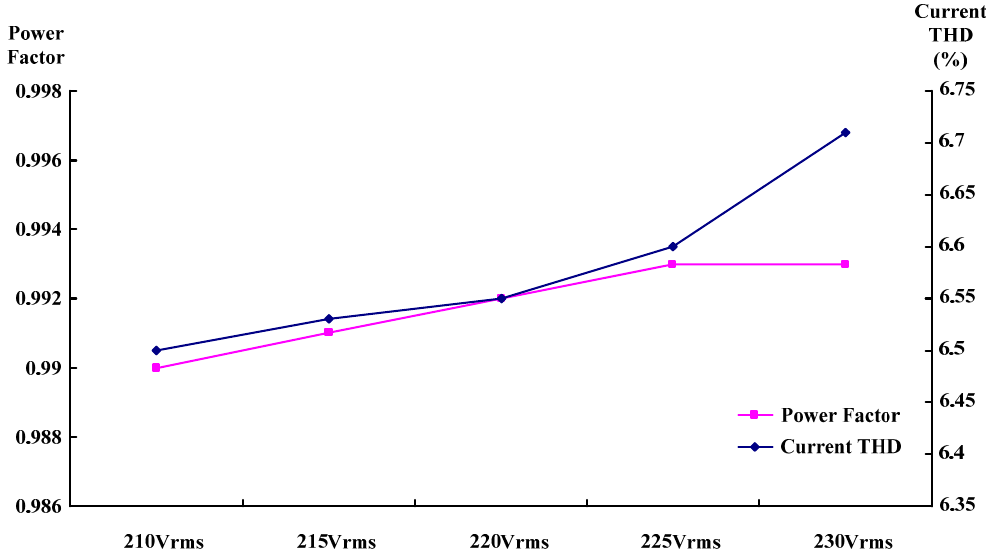
Figure 16. Measured power factor and current total harmonic distortion (THD) under utility-line voltages ranging from 210 to 230 V.